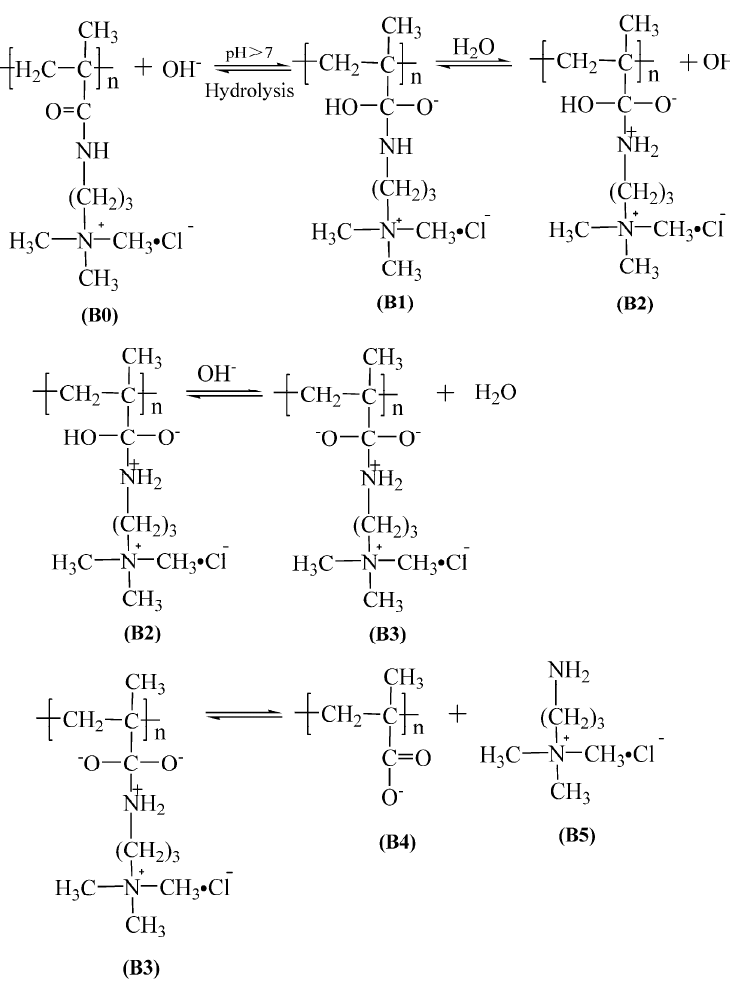
Figure 16. Base-catalyzed amide hydrolysis mechanism of PMAPTAC.